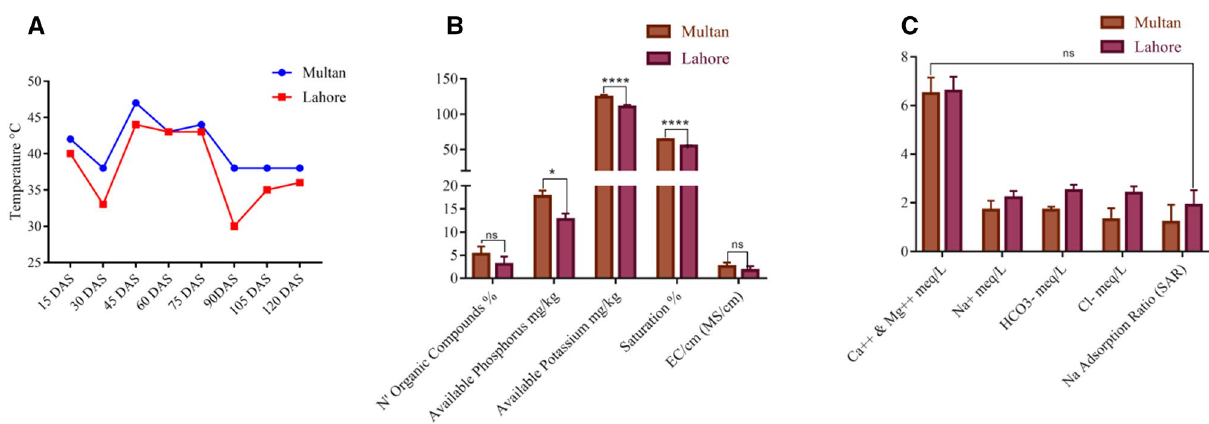
Figure 2. Graphical representation of temperature, soil nutrients and water analyses ( A ) Temperature data of Multan and Lahore fields ( B ) Soil Nutrients ( C ) Water analysis used for Liver function test (LFT), renal function test (RFT) and serum electrolyte.